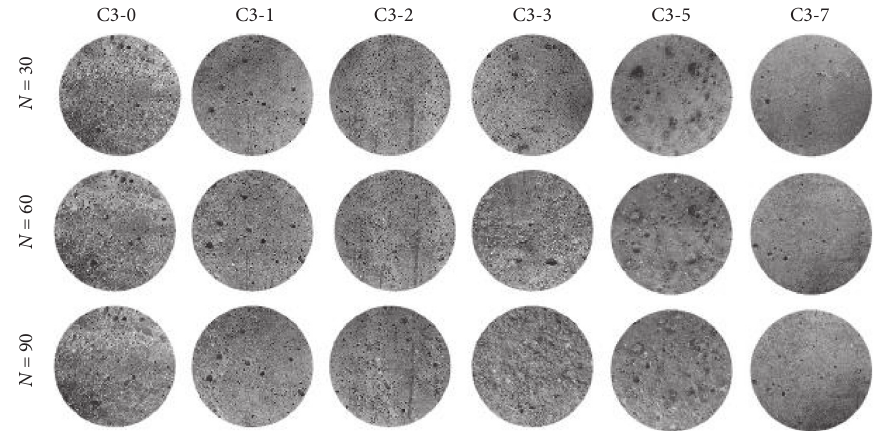
Figure 8: Surface spalling for concrete after different freezing-thawing cycles.